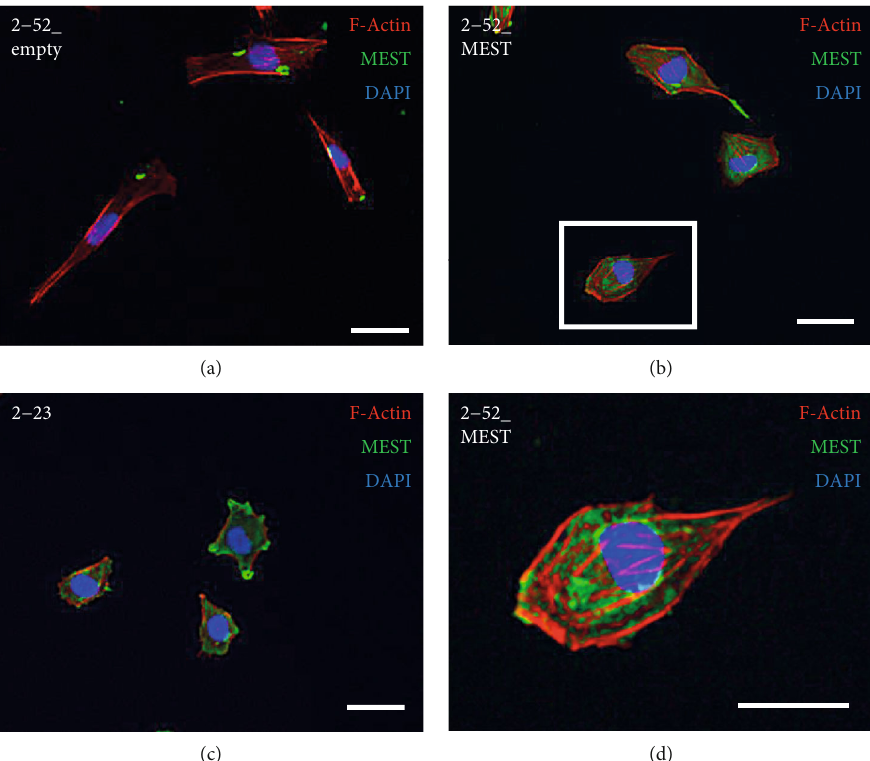
Figure 7: The e ff ects of MEST overexpression on the cell morphology in 2-52 cells. (a – c) The cell morphology was investigated by immuno fl uorescence staining in 2-52_empty (a), 2-52_MEST (b), and 2-23 cells (c). (d) Highly magni fi ed view of a boxed area in (b). Nuclei were stained with DAPI, and F-actin was stained with phalloidin (F-actin: red; anti-MEST: green; DAPI: blue; bars: 10 μ